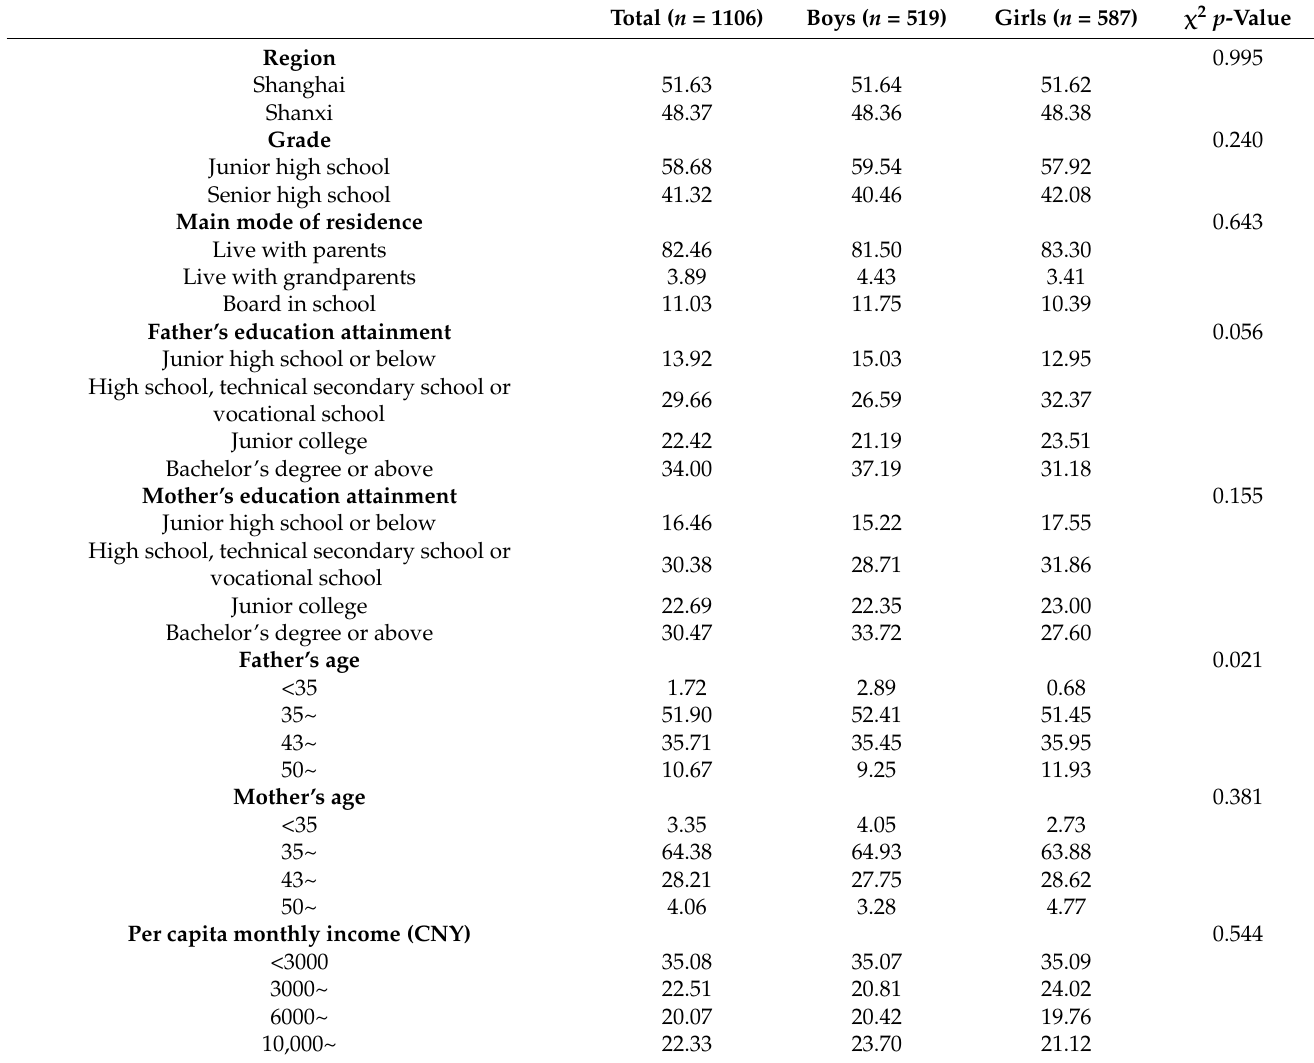
Table 1. Demographic characteristics of all respondents based on